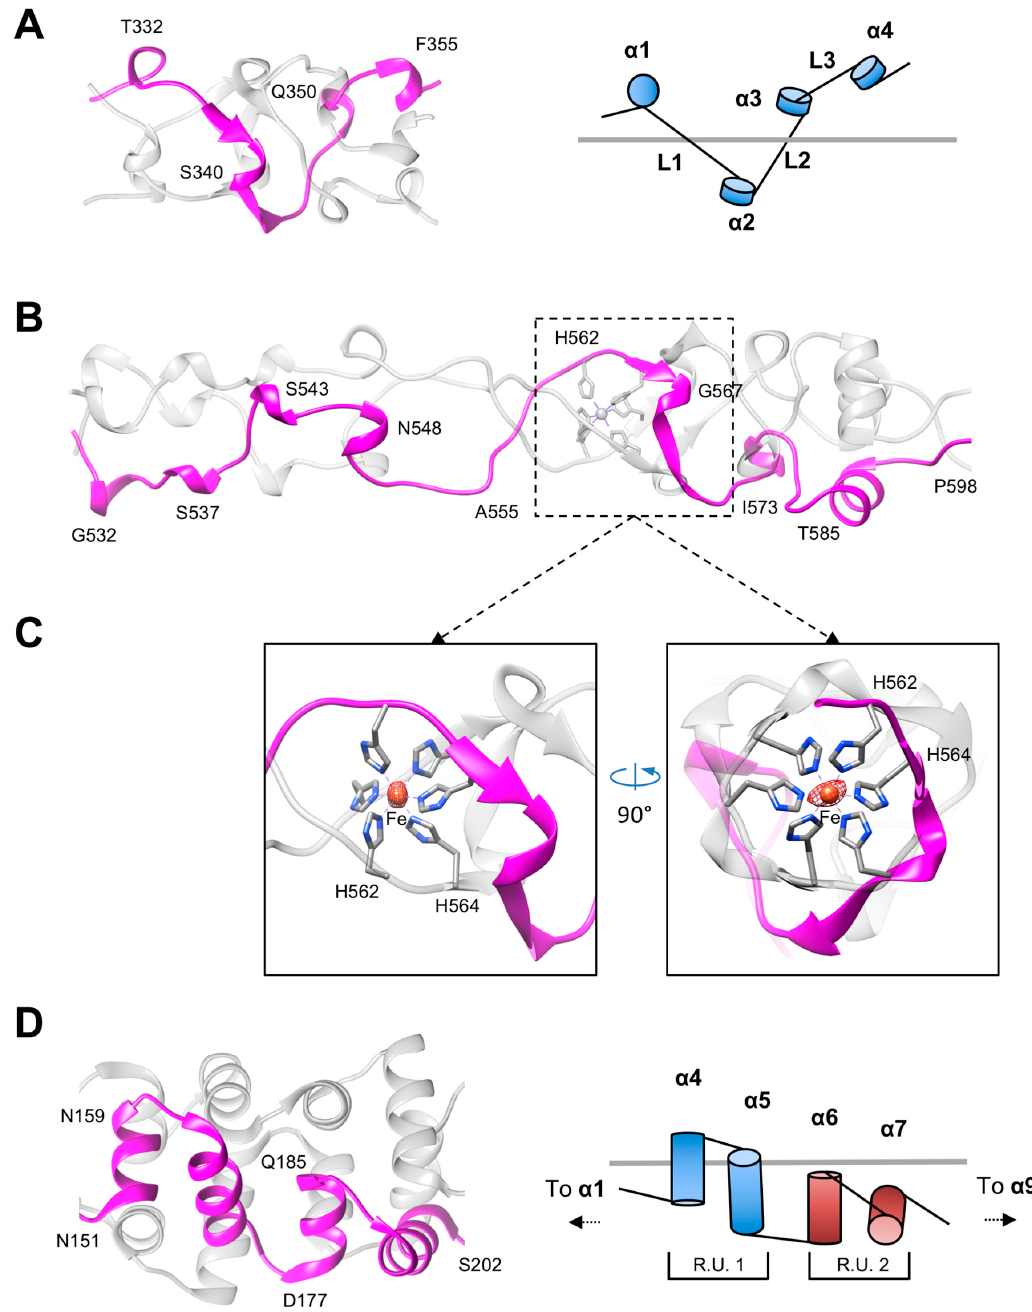
Figure 2. Detailed analysis of the Rod and Shaft domains. The fold and schematic topology overview of the Rod ( A ) and Shaft ( B ) domains. Linkers of variable length connecting the α -helices ( α 1– α 4) are labeled L1, L2, and L3. ( C ) Side view and N-to-C end-on view of the iron-binding motif that is located approximately in the middle of the Shaft domain. The sidechains of histidines constituting the binding site are showed in a stick representation. The centrally positioned iron ion is shown as a rust-colored sphere. The Bijvoet difference Fourier synthesis map is shown as a red mesh and contoured at 4.0 standard deviations above the mean. His-N ε 2-Fe coordination bonds are showed with dashed lines. One monomer is colored in magenta and the other two are colored in transparent grey. The R2 fiber model was used for illustration. ( D ) The fold and schematic topology overview of the stem domain fragment of phage phi29 head fiber. R.U. stands for Repeating Unit.